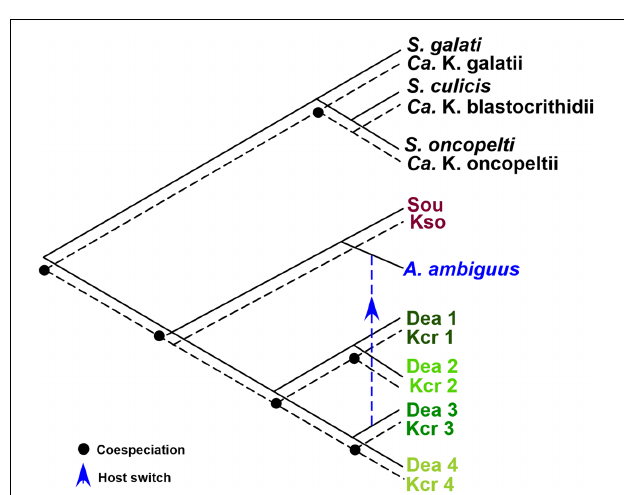
FIGURE 6 | Tanglegram of coevolutionary patterns between Angomonas hosts (SHTs) and symbionts (TPEs), strongly supporting ( p < 0.002) codivergence between species/genotypes of SHTs and species/genotypes of TPEs. The only exception was a single host switch between A. ambiguus and the symbiont Kcri3 of A. deanei Dea3. Tanglegram generated by TreeMap using the MP topologies inferred with gGAPDH sequences from SHTs and GAPDH from TPEs (showed in Figure 5